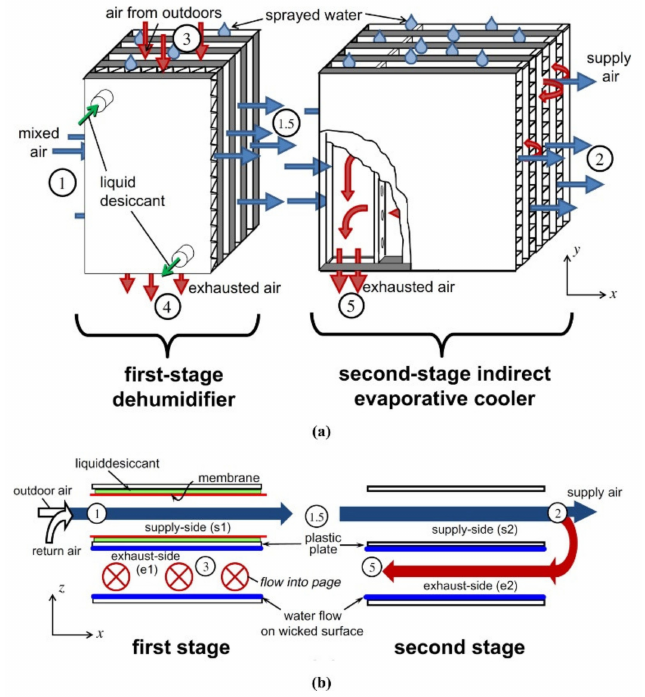
Figure 3. The combined desiccant dehumidifier + IEC system ( a ) front view of stacked channels, and ( b ) top view of a single channel pair. Reprinted with permission from Ref. [40]. Copyright 2016,